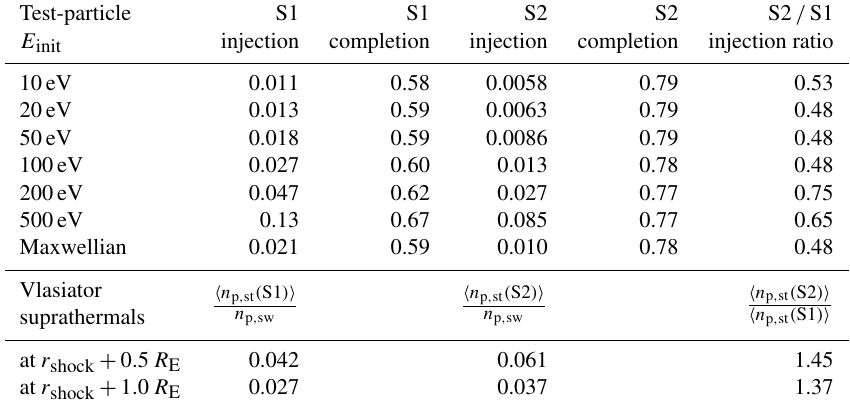
Table 1. Test-particle proton statistics using simulations S1 ( M A ≈ 10) and S2 ( M A ≈ 5) with six different solar wind frame initialization energies E init and also a Maxwellian initialization distribution with a temperature of 0.5MK. Columns list the estimated injection probability N inj /(N inj + N tra ) and the completion ratio (N inj + N tra )/N init . Also shown is the ratio of injection probabilities for S2 and S1. The final two rows show suprathermal proton density measurements (cid:104) n p , st (cid:105) extracted from Vlasiator simulations S1 and S2 at positions 0.5 and 1.0 R E upstream of the mean bow shock position, averaged over nose angles between ± 45 ◦ and the test-particle run time extent. Test-particle